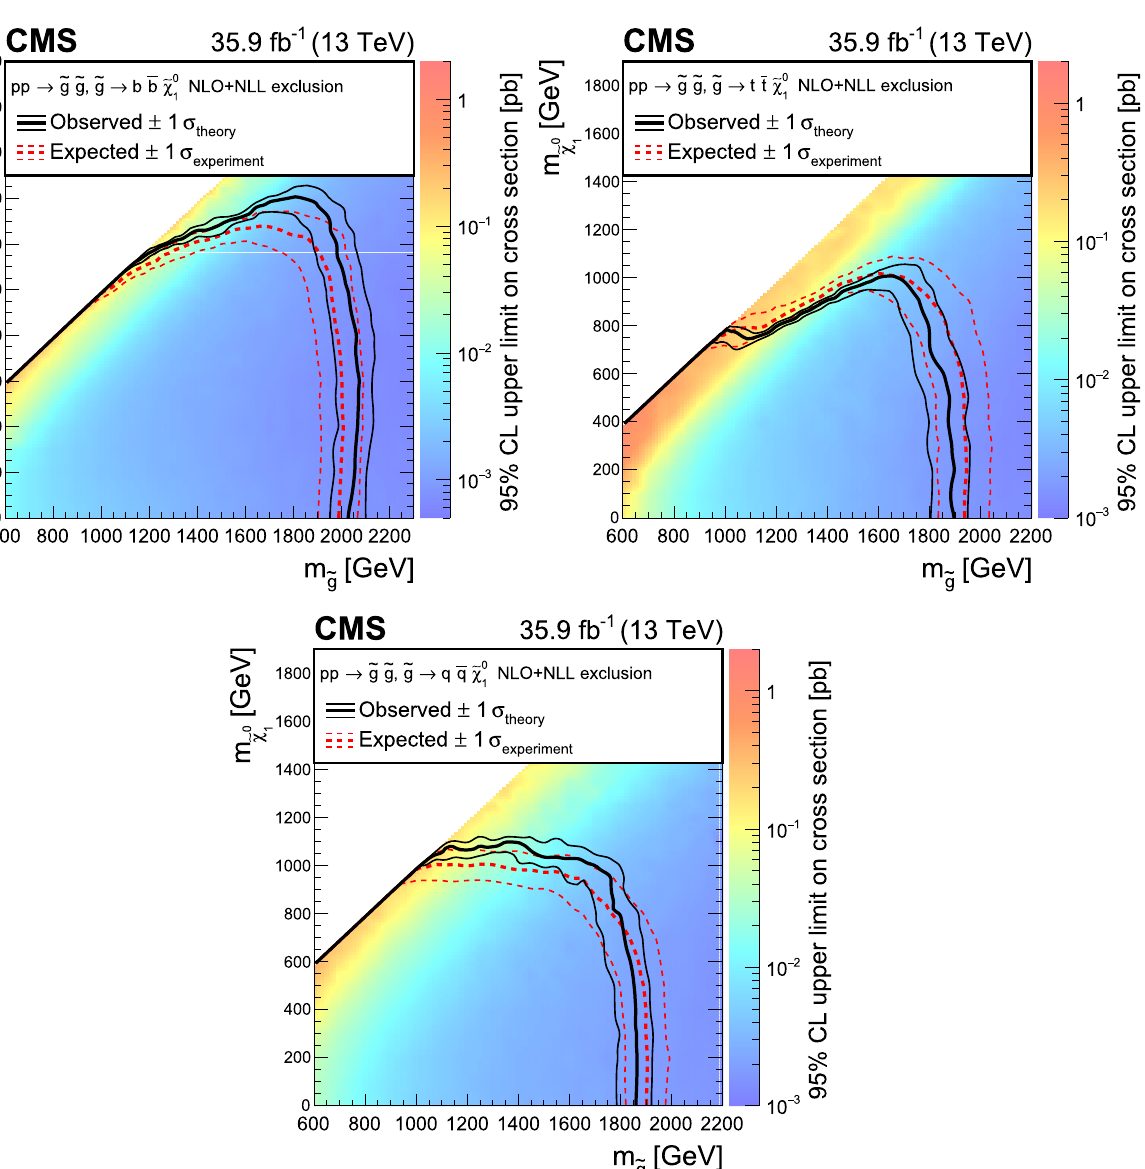
Fig. 6 Exclusion limits at 95% CL for gluino-mediated bottom squark production (upper left), gluino-mediated top squark production (upper right), and gluino-mediated light-flavor (u,d,s,c) squark production (below). The area enclosed by the thick black curve represents the